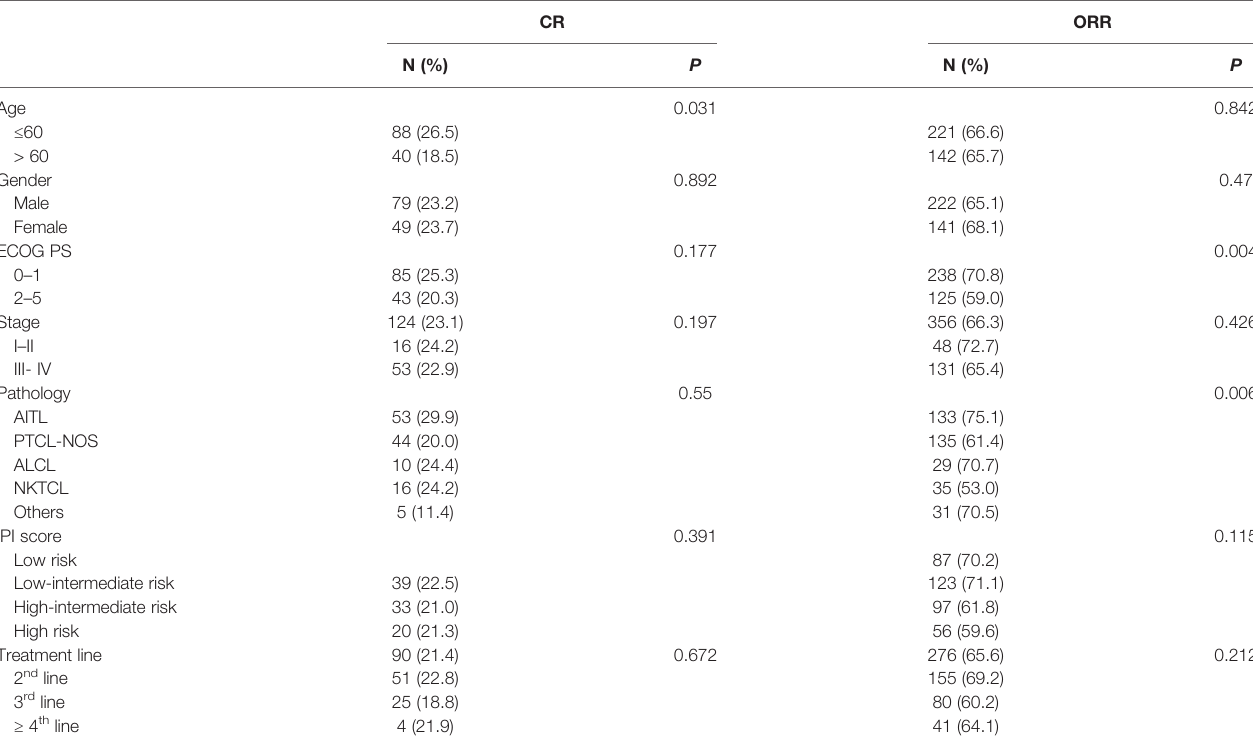
TABLE 2 | Ef fi cacy of chidamide-based treatment strati fi ed by baseline characteristics.